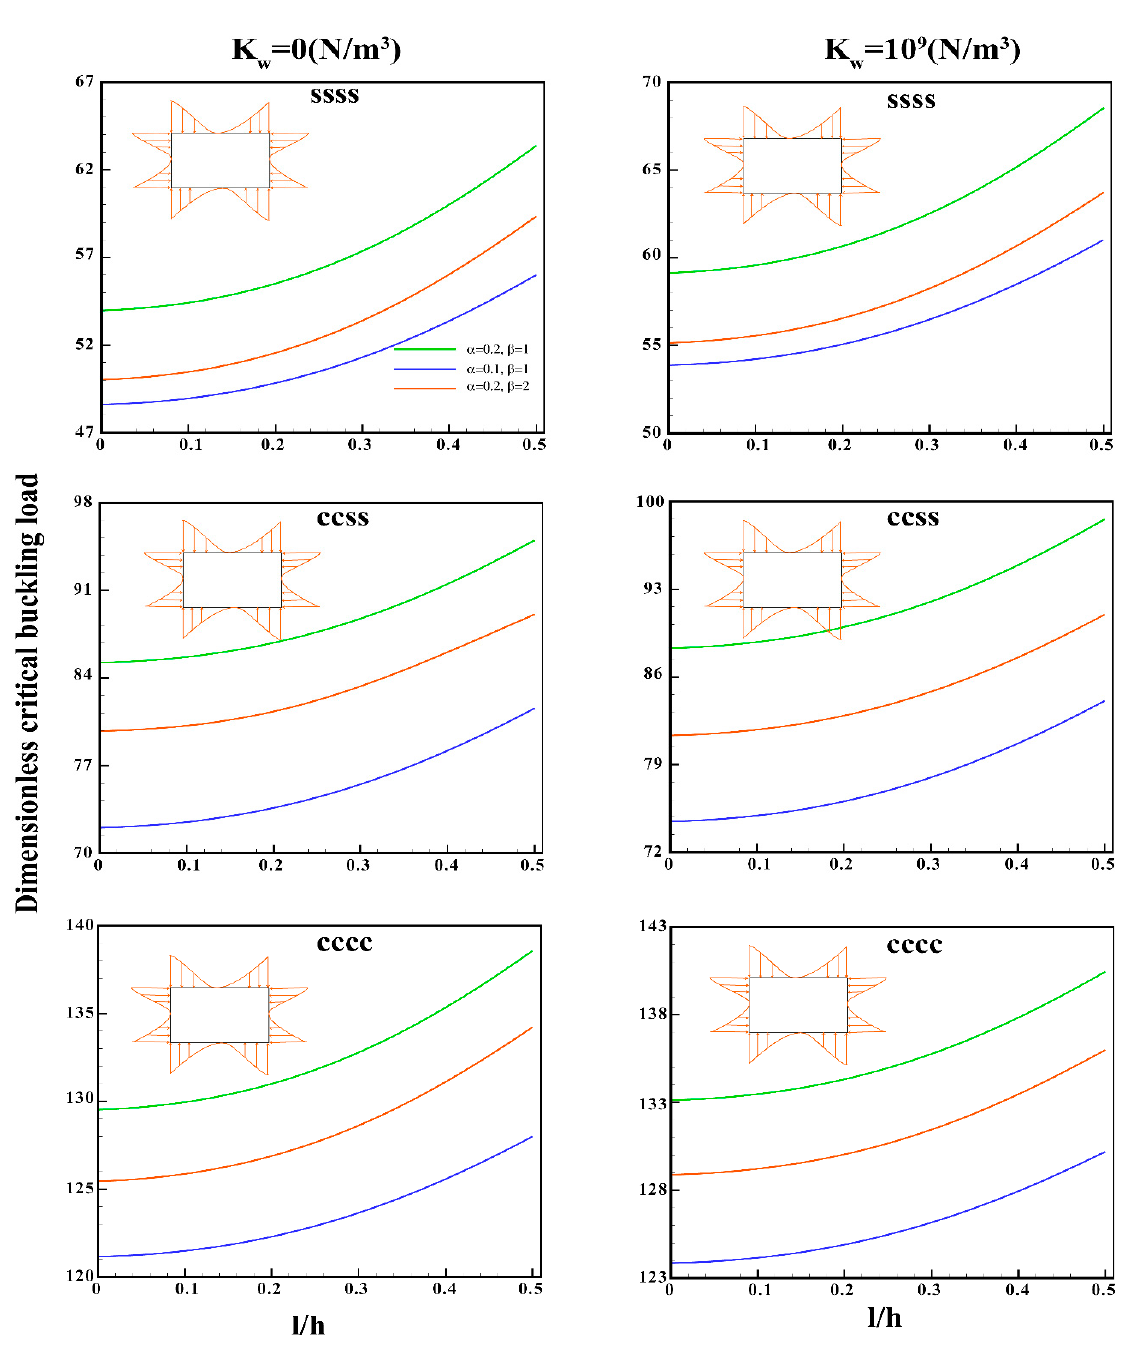
Figure 5. Variations of the dimensionless biaxial buckling load of the UD-CNTRC microplate against the material length scale parameter to thickness ratio for different boundary conditions and different values of the elastic medium stiffness parameter (reverse sinusoidal edge compressive load).